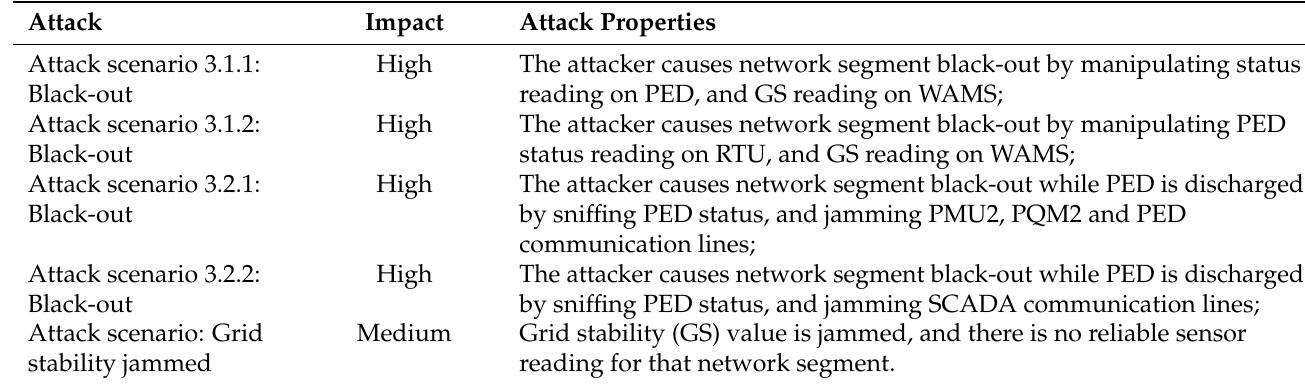
Table 15. Modeled attacks, their impact and properties for UC3.